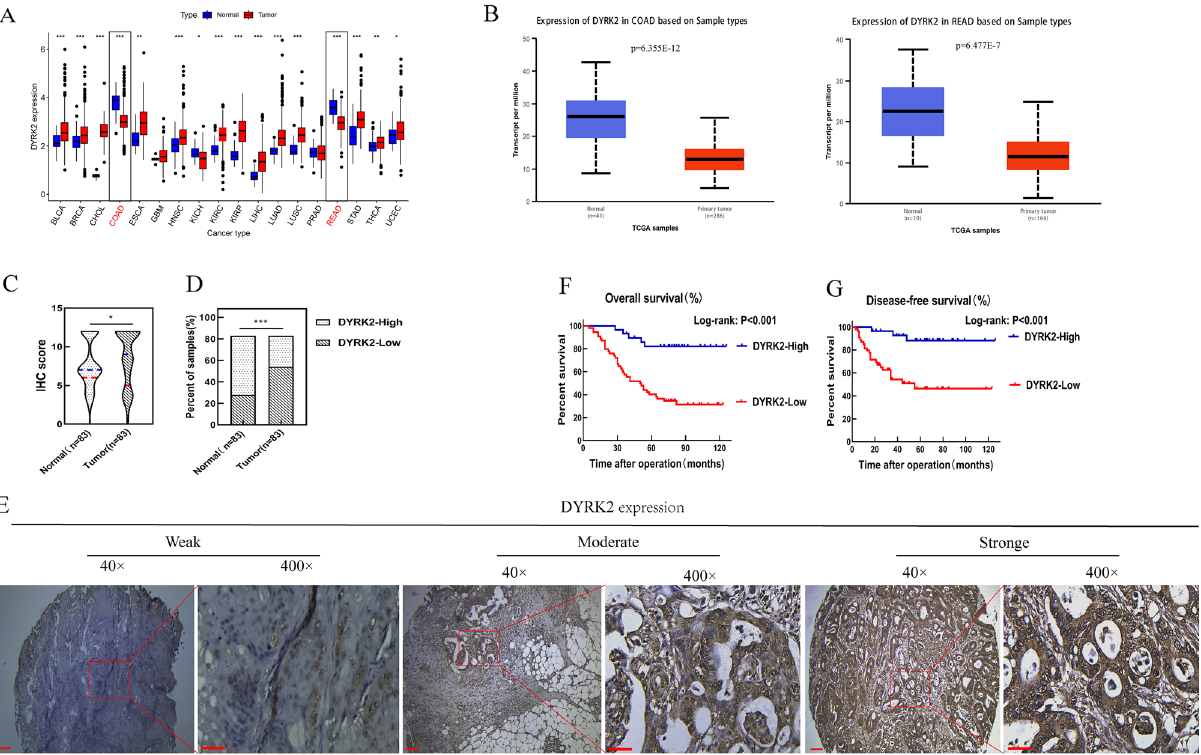
Figure 1. Analysis of the clinicopathological correlates of DYRK2 expression in CRC. ( A ) Pan-cancer DYRK2 mRNA expression profiles in humans were assessed using the TIMER database, revealing DYRK2 upregulation in 13 tumor types (BLCA, BRCA, CHOL, ESCA, HNSC, KIRC, KIRP, LIHC, LUAD, LUSC, STAD, THCA, UCEC), and downregulation in 3 tumor types (COAD, KICH, READ), RNA-Seq was conducted via